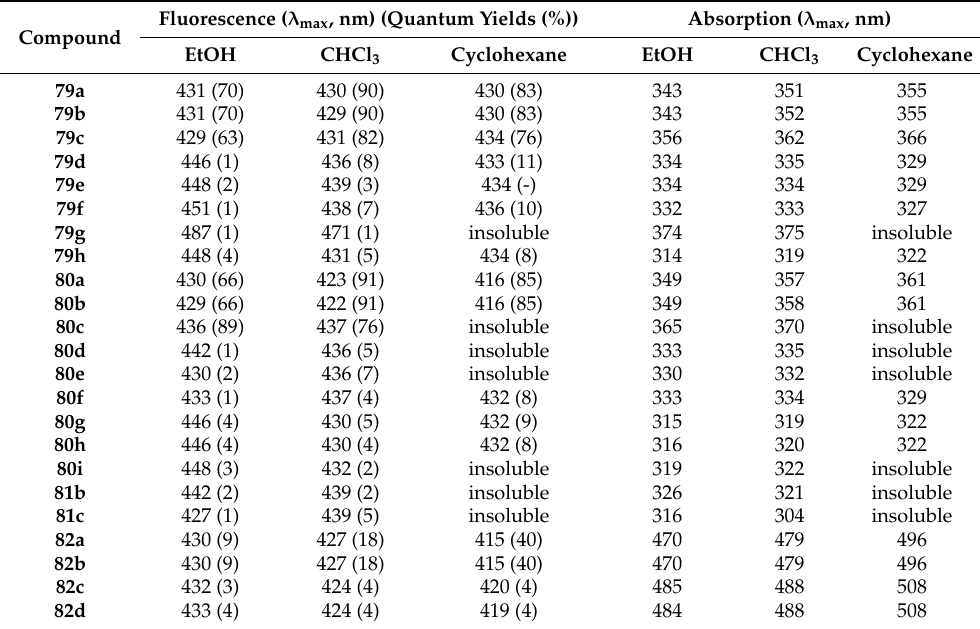
Table 14. λ max (nm) of absorption spectra, fluorescence spectra, and relative quantum yields (%) of PD compounds 79 – 82